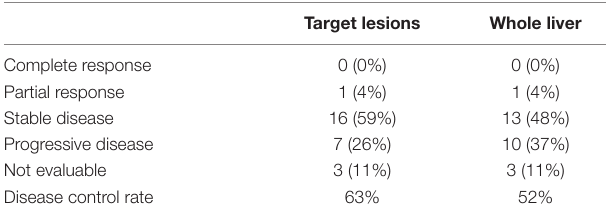
TaBle 4 | Tumor response to sirT at the target lesion and whole-liver level after 3 months of follow-up.